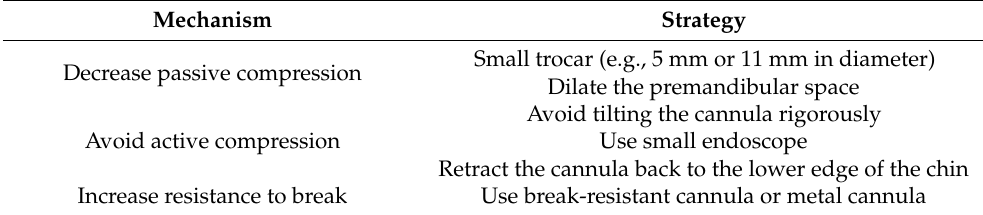
Table 3. Strategies for preventing cannula fracture.